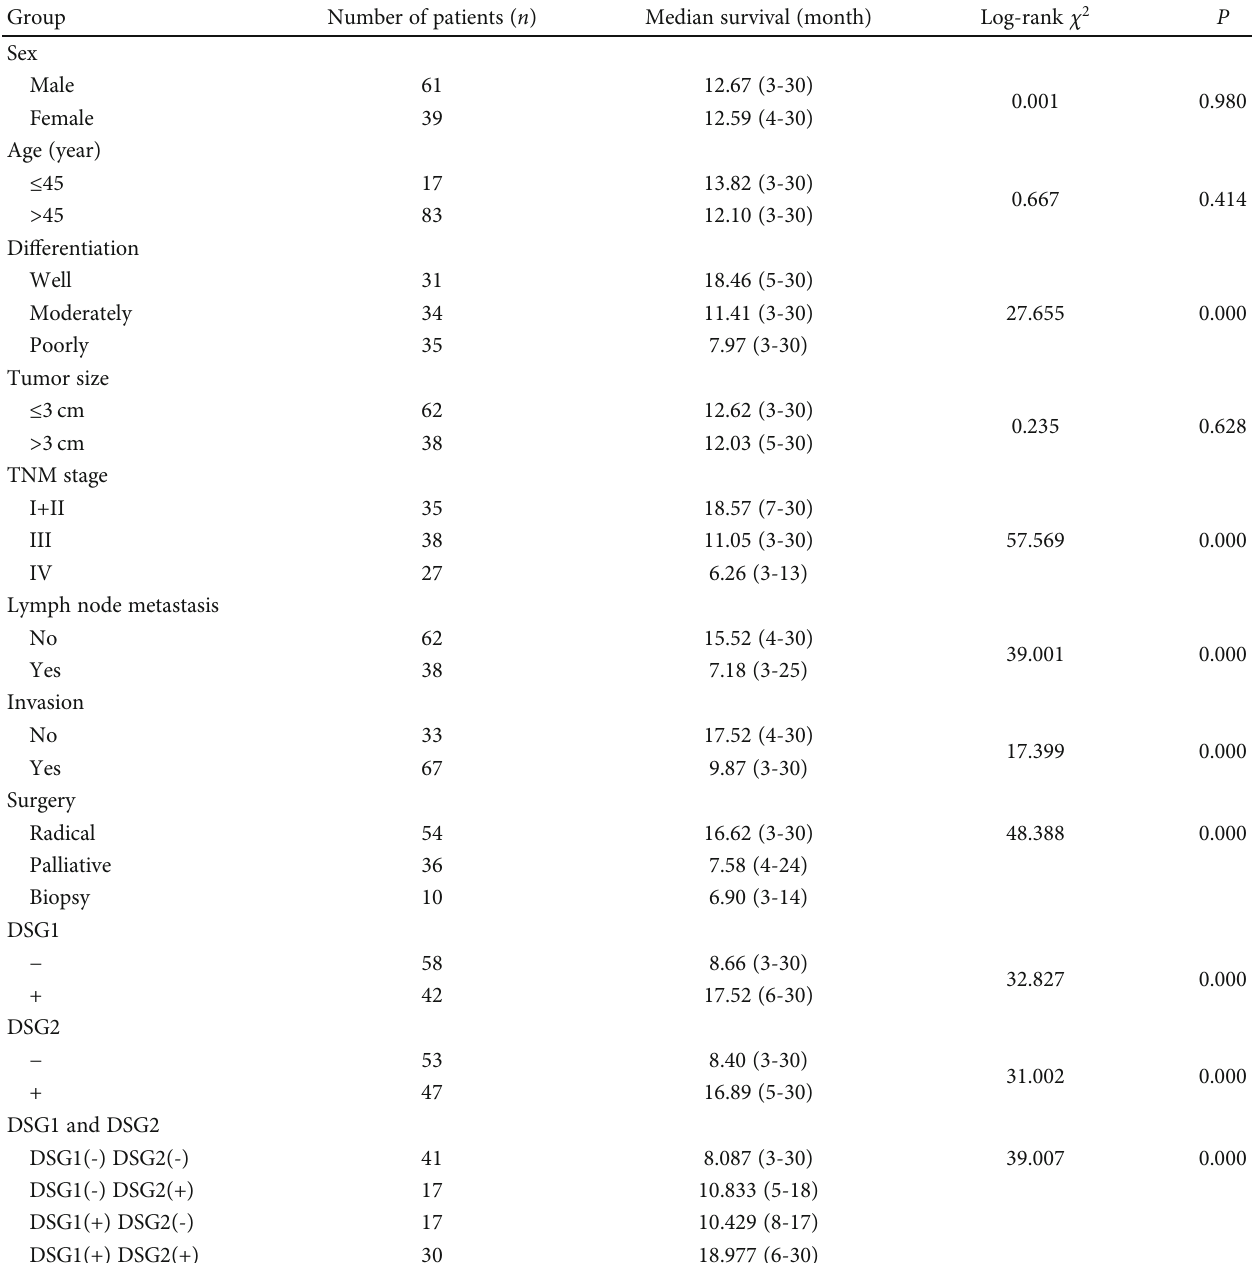
Table 4: Correlations of clinicopathological characteristics, DSG1 and DSG2 expression with the mean survival in patients with EHCC.